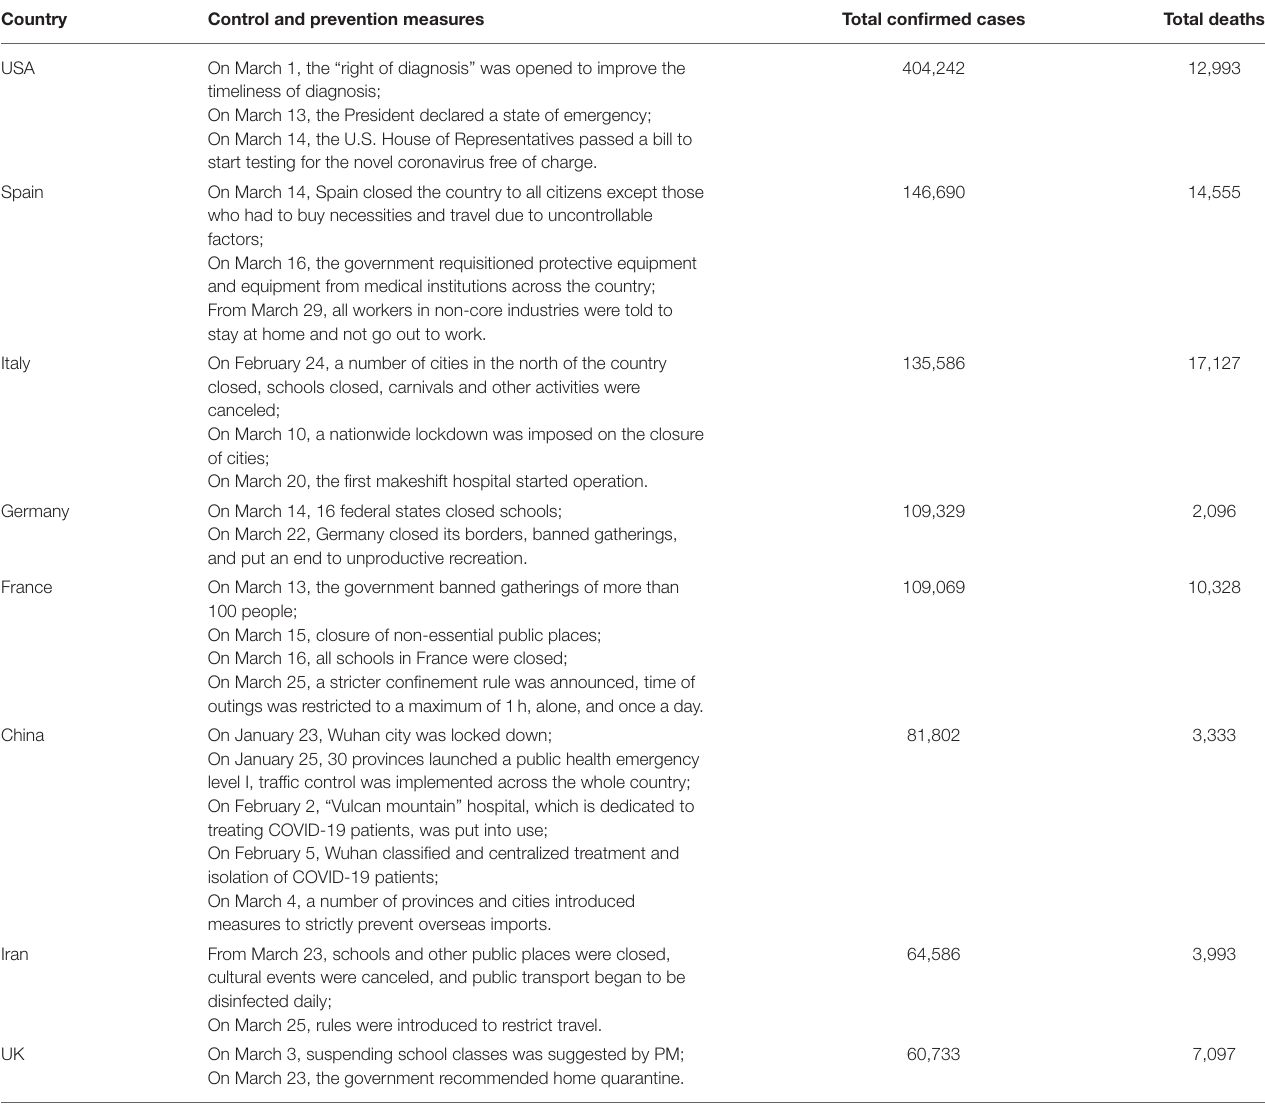
TABLE 1 | Milestones of COVID-19 containment policy and virus spread situation in major affected countries (as of April 8, 2020). Country Control and prevention measures Total confirmed cases Total deaths